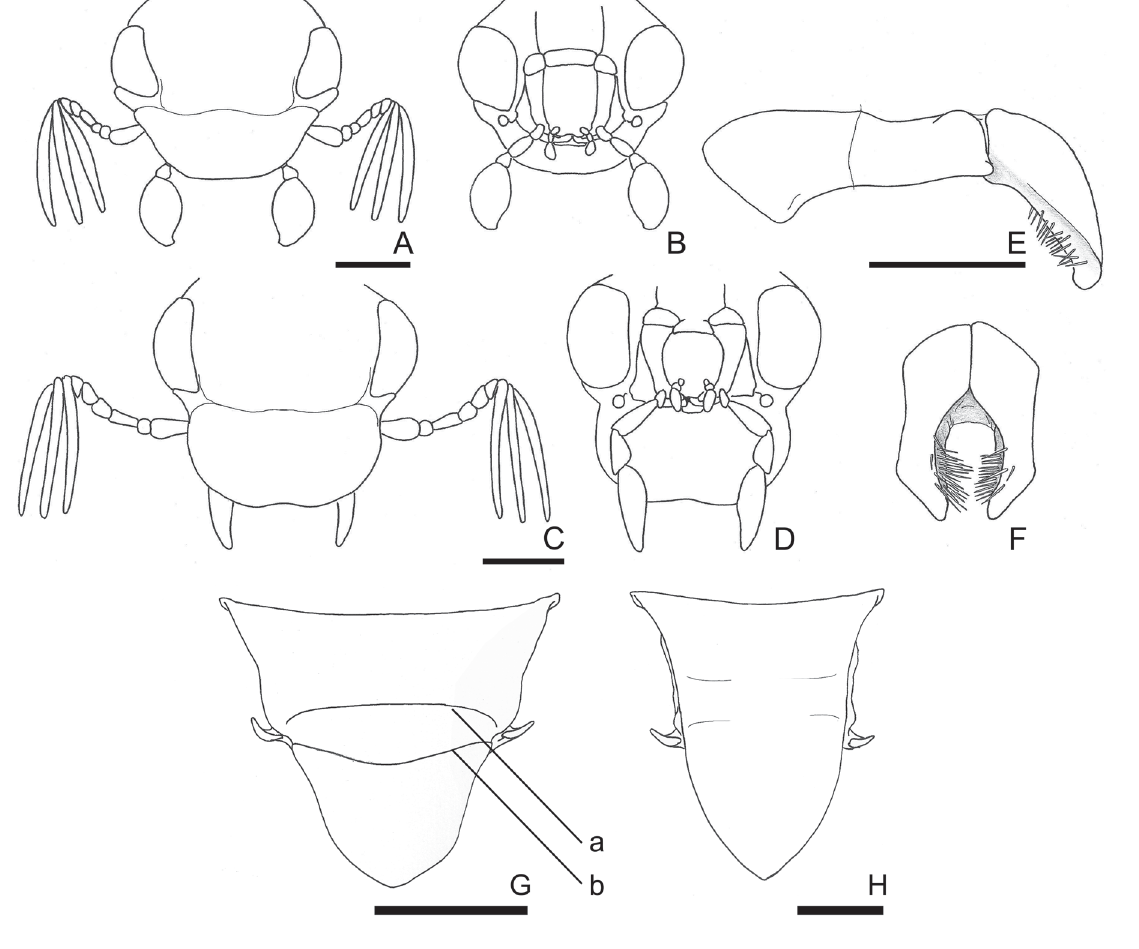
Fig. 6. ♂♂. A–D . Head (dorsal, ventral). E–F . Aedeagus (lateral, parameres apex). G–H . Mesoalinotum. A–B , E–F . Clavipalpus dejeani Laporte, 1832. C–D . Paulosawaya ursina (Blanchard, 1850) comb. nov. G . Barybas nana Blanchard, 1850. H . Macrodactylus pumilio Burmeister, 1855. a = scutum transverse carina; b = scutum–scutellum limit angulate. Scale bars = 1